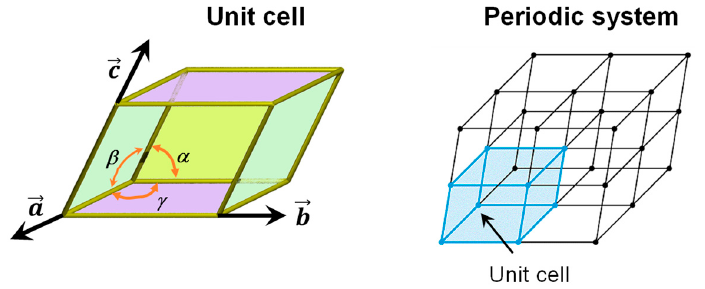
Figure 1. Representation of a generic unit cell (including the lattice parameters) and its repetition along the 3D space generating a periodic system.